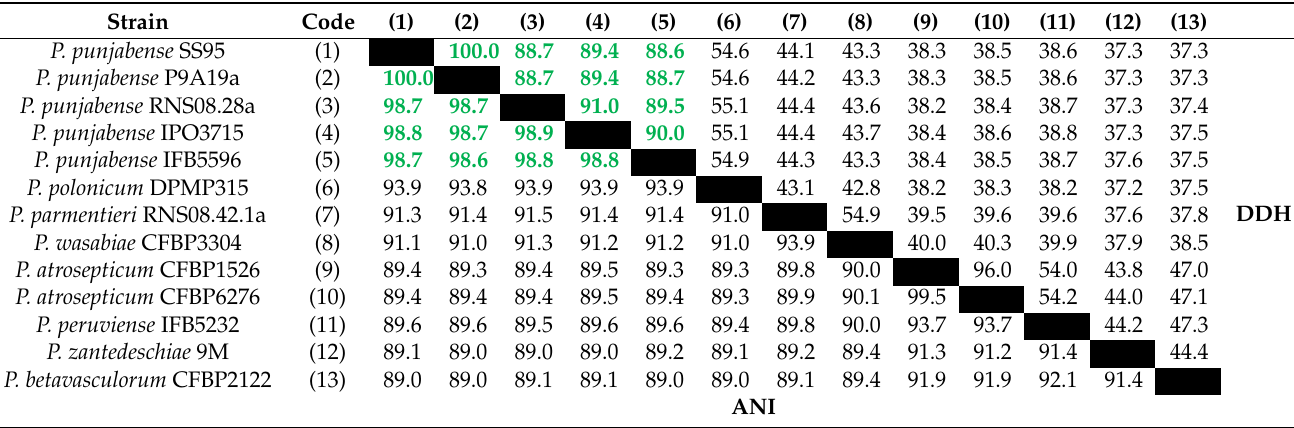
Table 2. Average nucleotide identity (ANI) and DNA–DNA hybridization (DDH) values for each genome comparison. Comparison between P. punjabense strains are marked in